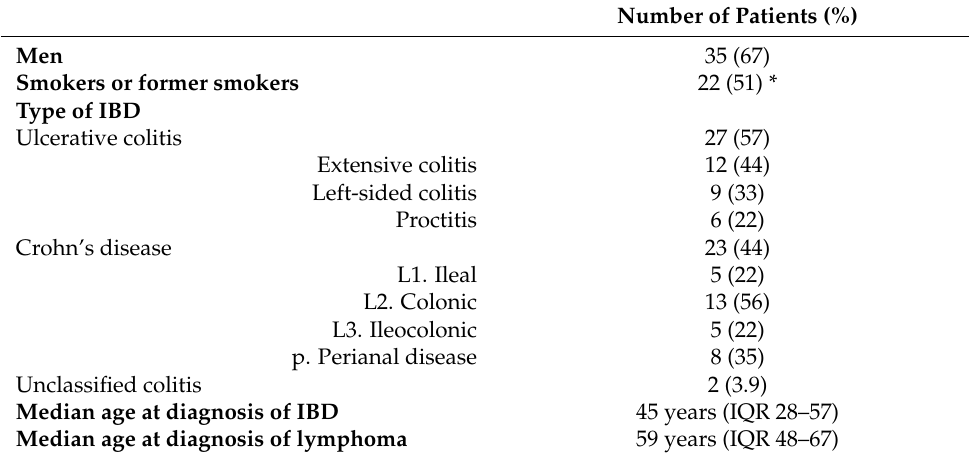
Table 1. Characteristics of the patients. IBD: inflammatory bowel disease. IQR: interquartile range. * Forty-three patients had this data